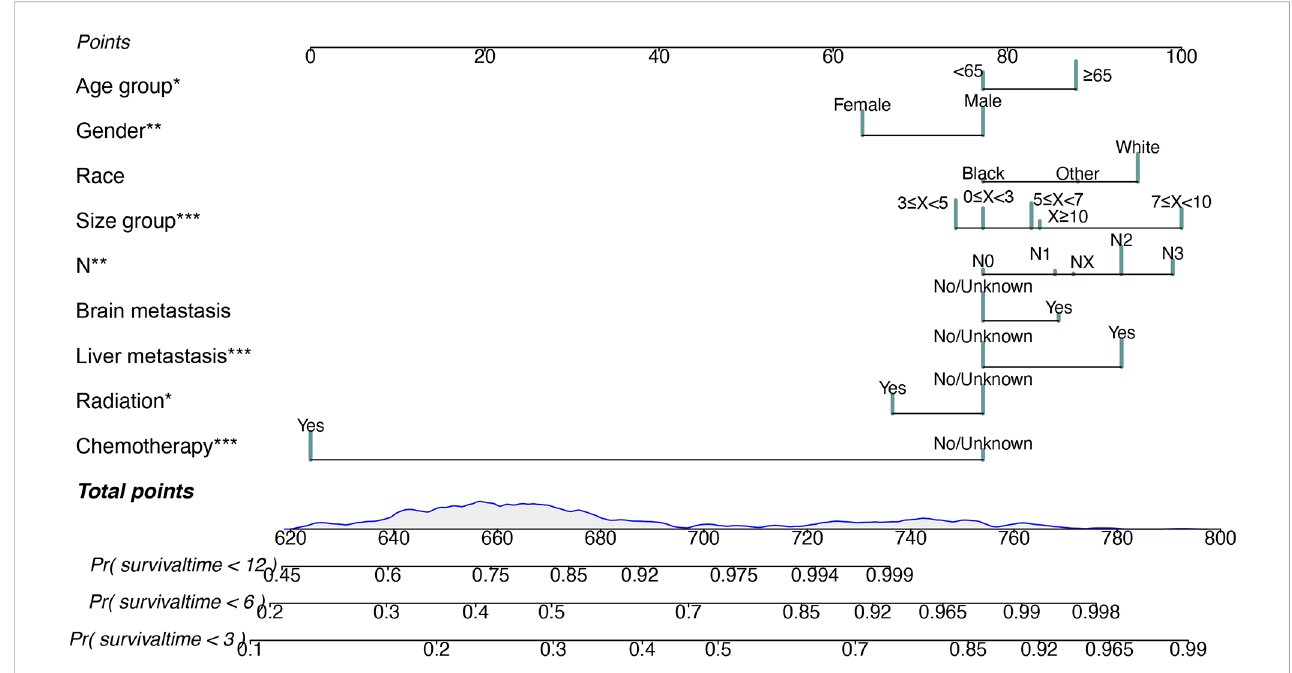
FIGURE 3 Nomogram for predicting 3-month, 6-month and 12-month overall survival in SCLC patients with BM. *P < 0.05, **P < 0.01, ***P <